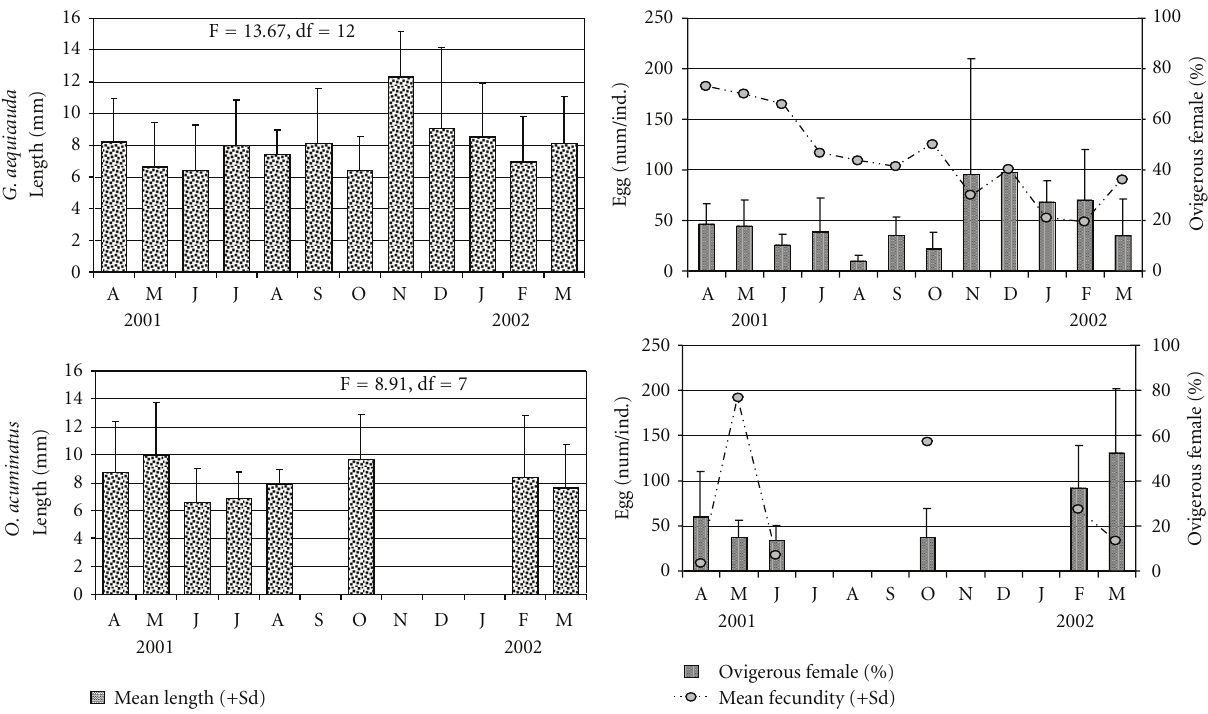
Figure 4: Mean length (mm), fecundity (egg/ind.), and frequency of ovigerous female for each species during April 2001 to March 2002.